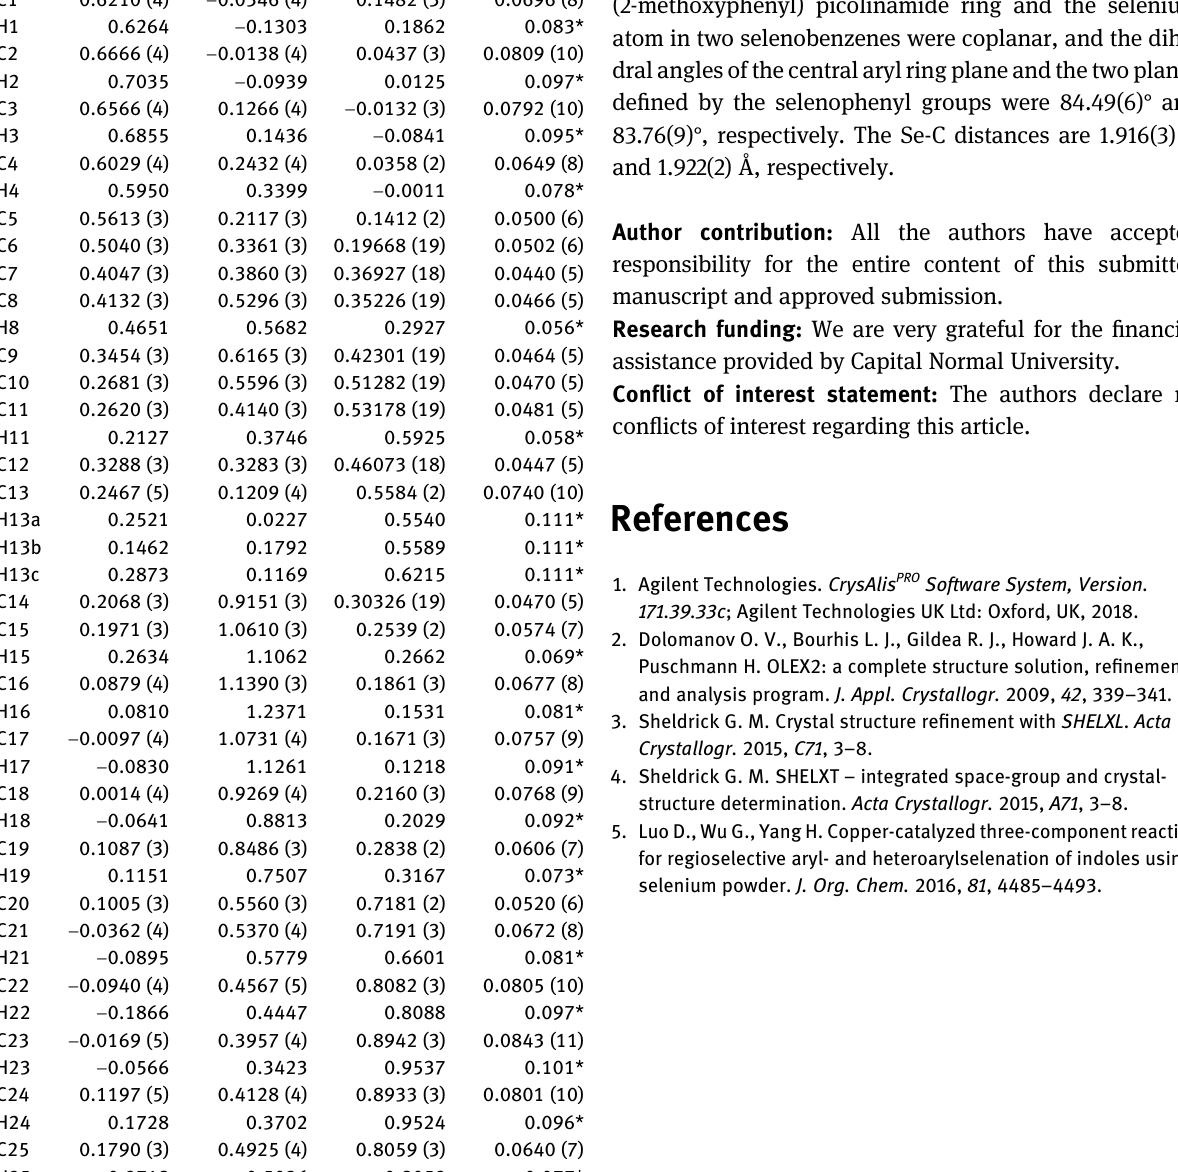
Table  : Fractional atomic coordinates and isotropic or equivalent isotropic displacement parameters (Å 